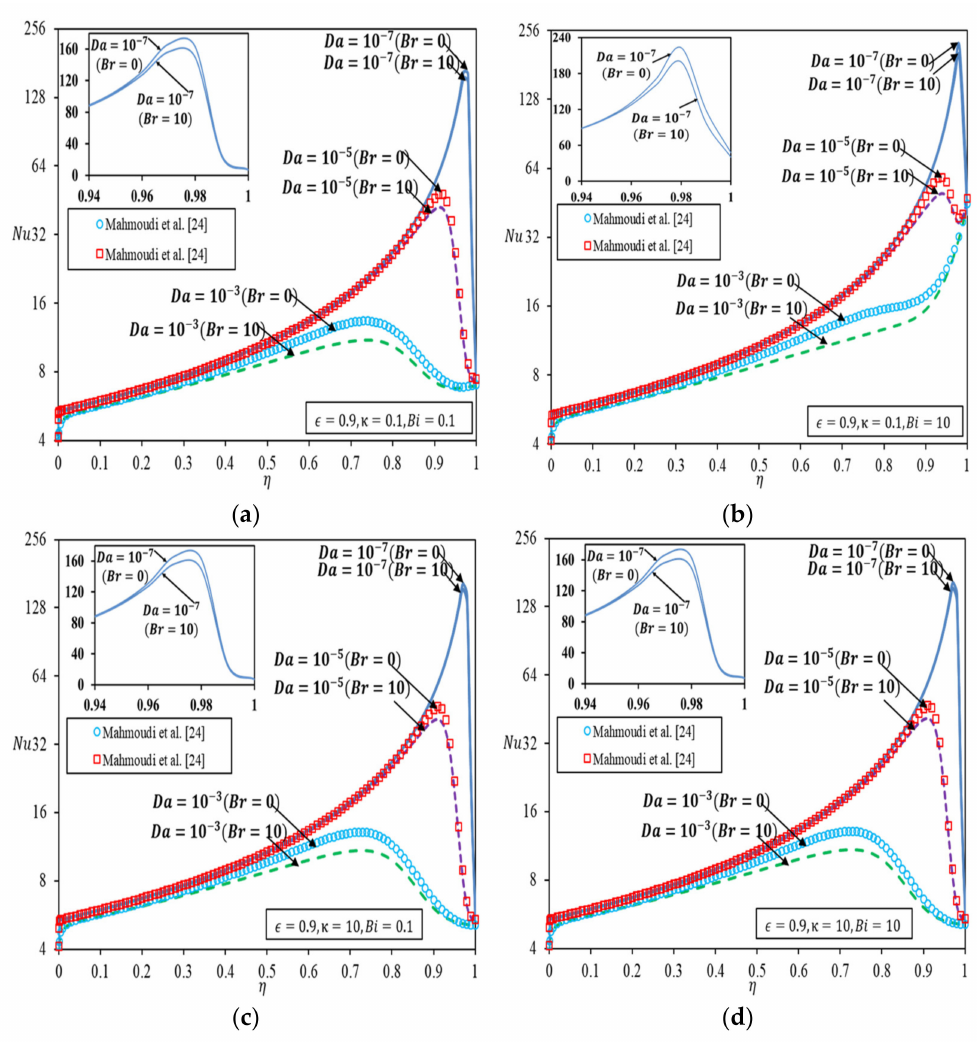
Figure 4. Nusselt number versus thickness of porous medium [24] ( a ) κ = 0.1, Bi = 0.1; ( b ) κ = 0.1, Bi = 10; ( c ) κ = 10, Bi = 0.1; ( d ) κ = 10, Bi =